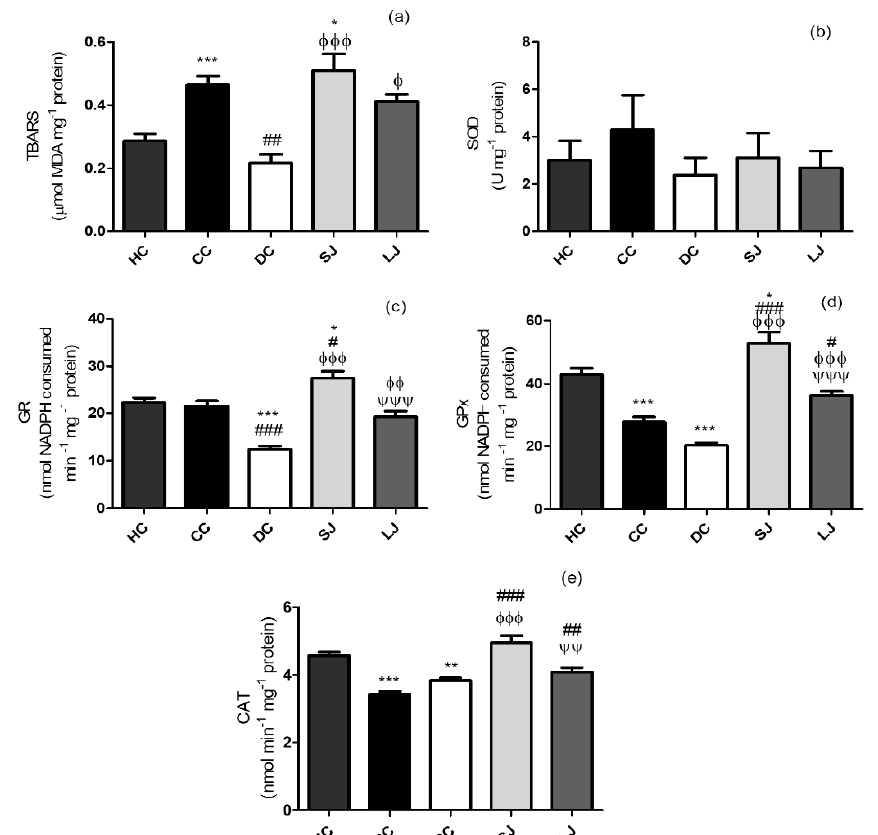
Figure 3. Lipid peroxidation and antioxidant defenses of colon. ( a ) Thiobarbituric acid reactive substances assay - TBARS ( µ mol malondialdehyde-MDA); ( b ) SOD (U); ( c ) GR (nmol nicotinamide adenine dinucleotide phosphate - NADPH consumed min − 1 ); ( d ) GPx (nmol NADPH consumed min − 1 ) and ( e ) CAT (nmol min − 1 ) mg − 1 protein. HC = healthy control; CC = colitis control; DC = drug (mesalazine) control; SJ = short-term EJP extract treatment; and LJ = long-term EJP extract treatment. Aqueous extract of Jaboticaba peel (EJP). Results are expressed as the mean ± standard error ( n = 6–8). * Indicates significant difference from HC group, # from CC group, Φ from DC, and Ψ from SJ by one-way ANOVA and Tukey’s test (1 code = p < 0.05; 2 codes = p < 0.01; and 3 = p < 0.001).